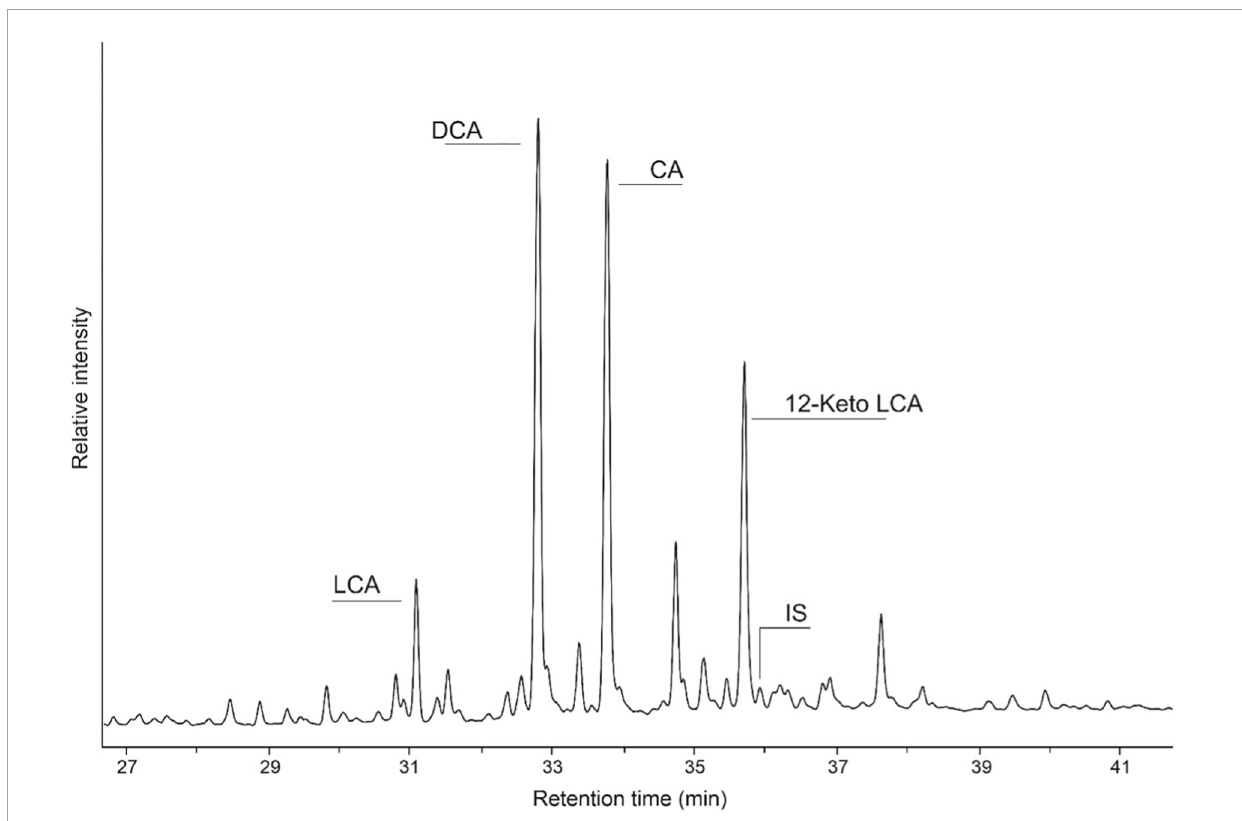
FIGURE4 Partial gas chromatogram illustrating the distribution of bile acids in a coprolite identified as human, where LCA is lithocholic acid, DCA is deoxycholic acid, CA is cholic acid (CA), and IS denotes the added internal standard hyocholic acid